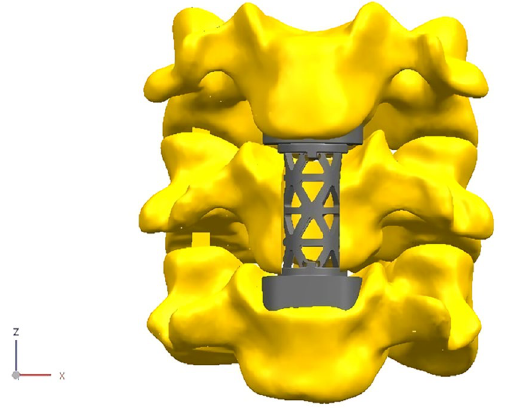
Figure 1. The novel anatomic titanium mesh cage for cervical spine (Solidworks 2016, SOLIDWORKS Co, USA).